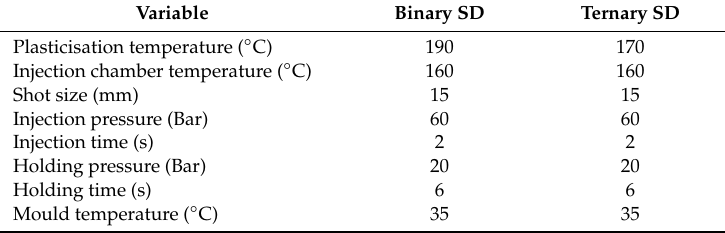
Table 2. Processing conditions for the µ IM of binary and ternary solid dispersions of poly(vinylpyrrolidone-vinyl acetate)- indomethacin (PVPVA-IND) and polyethylene oxide